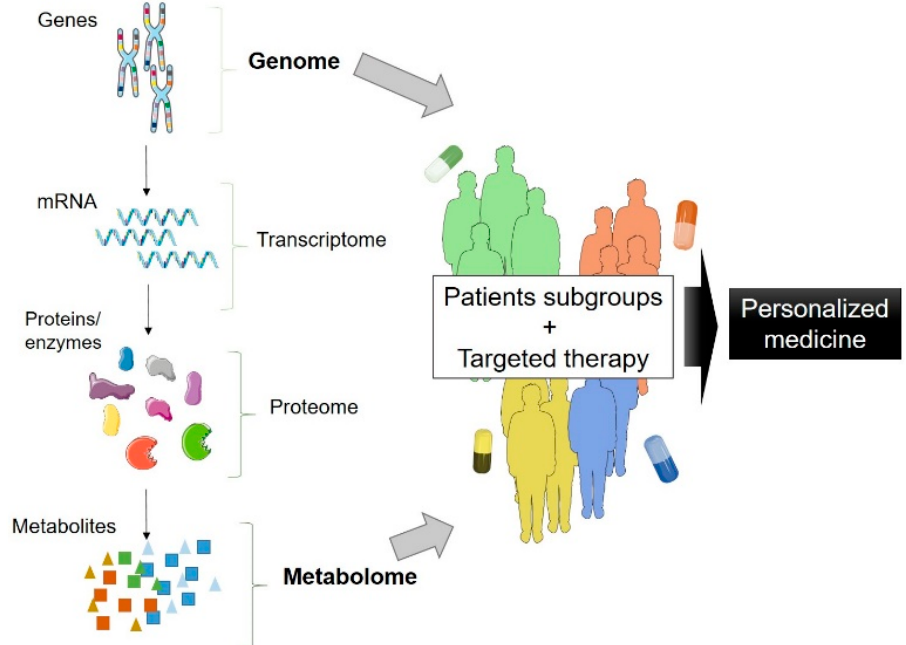
Figure 1. “Omics” approaches analyze the whole set of molecules in an organism, and the metabolome of an individual is ultimately influenced by the genetic background. By combining genotyping and metabolomics approaches, it is possible to identify subgroups of patients and design a targeted therapy for each case. Finally, combination of genetics, metabolomics, and targeted therapy will boost the development of a personalized medicine. The figure was designed using image templates from Servier Medical Art (https://smart.servier.com/image-set-download/).